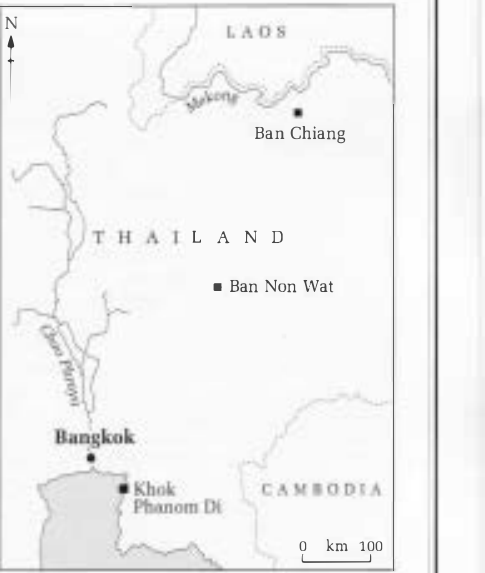
Figure 5 Thailand, showing the location of Neolithic sites mentioned in the